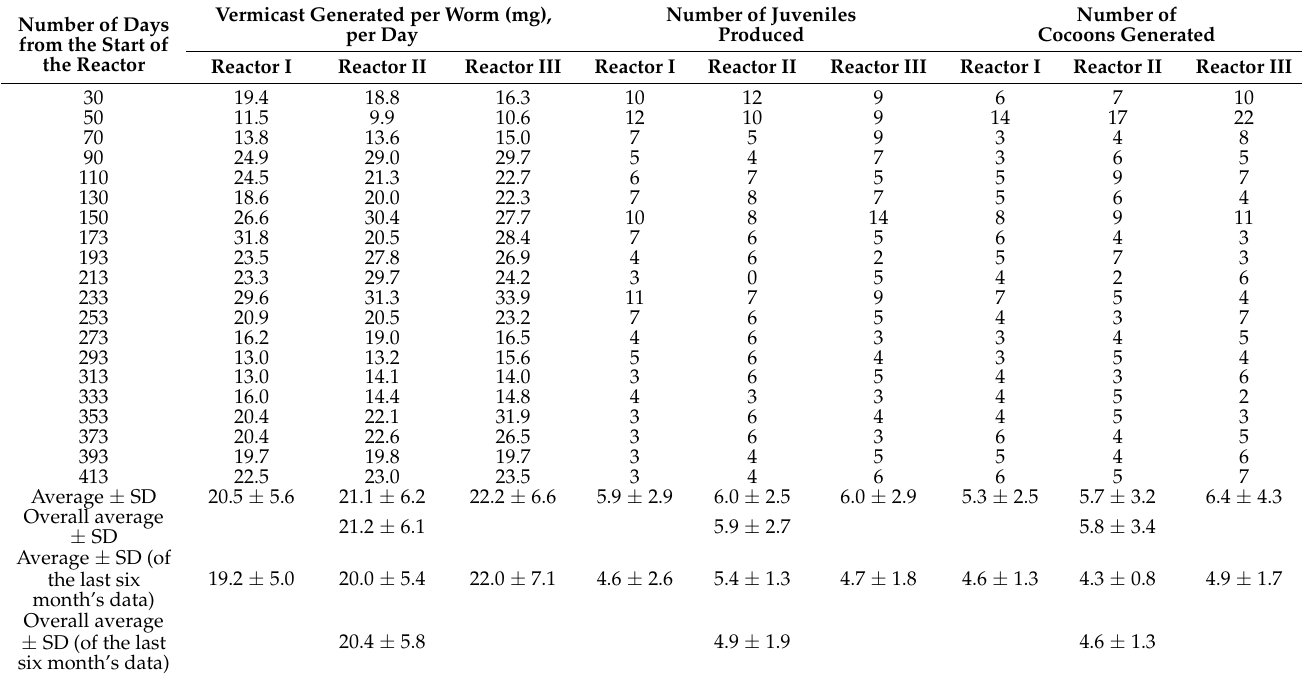
Table 11. Vermicomposting of ipomoea with 50 adults of E. fetida per kg of feed in pulse-fed